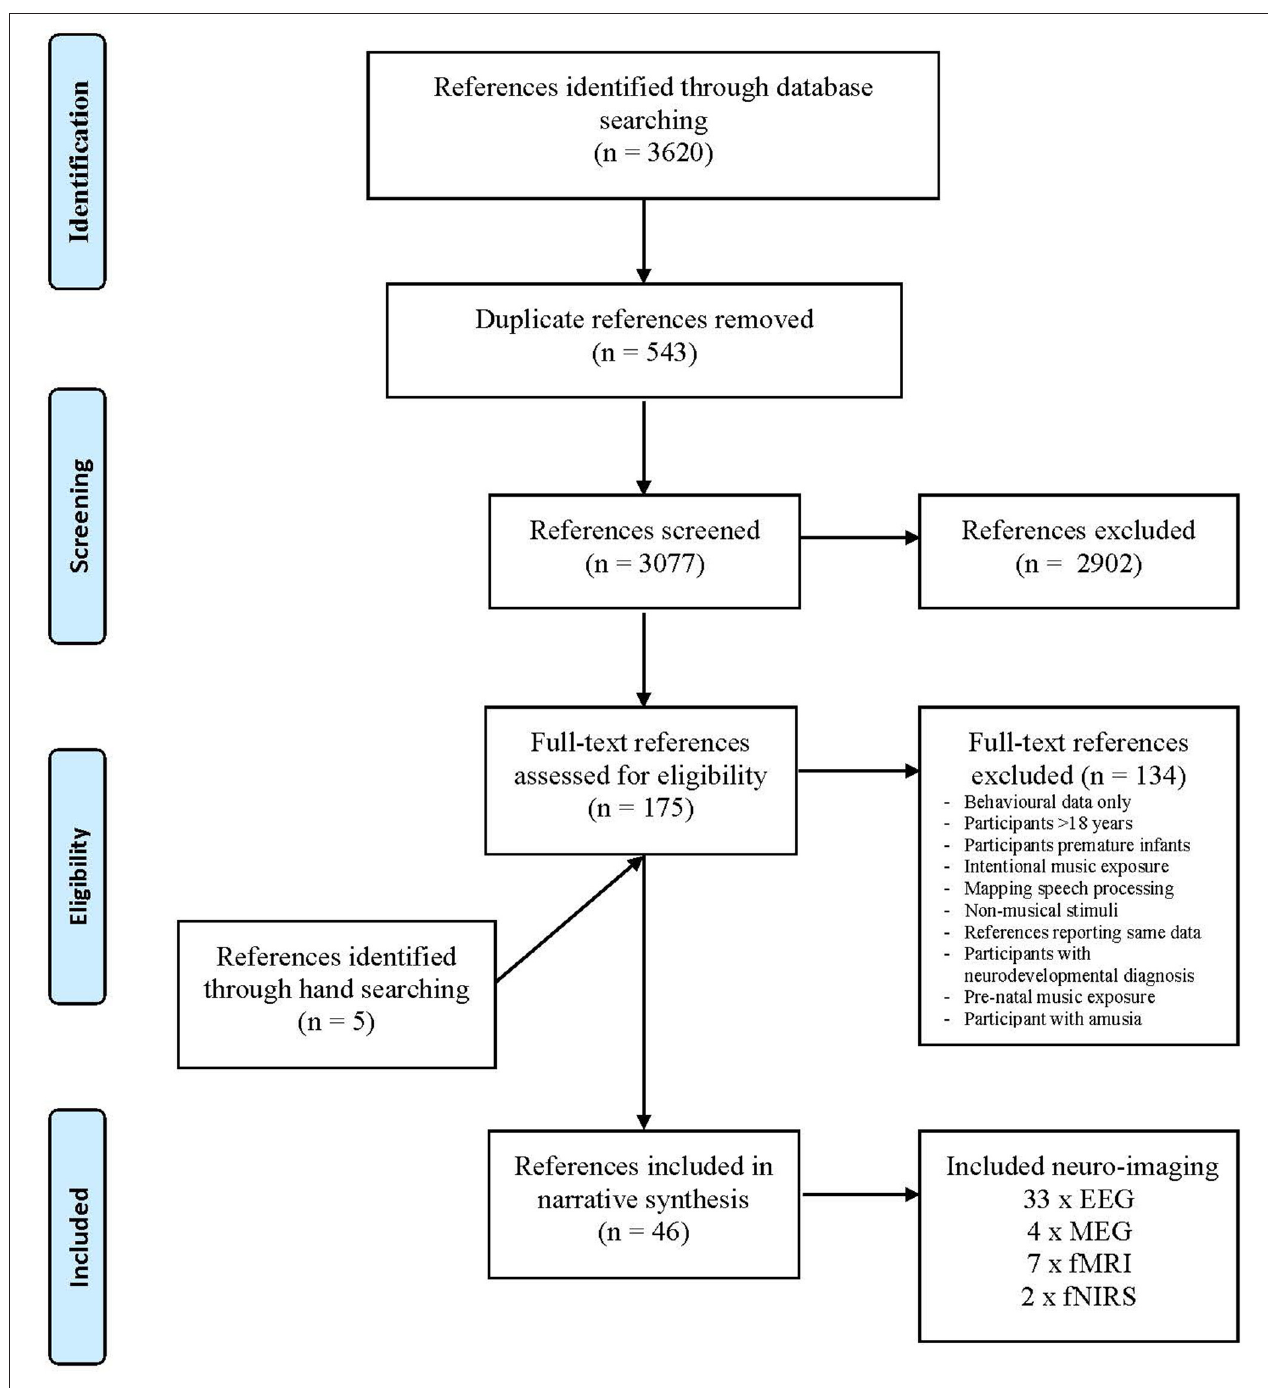
FIGURE 1 | Reference selection process. Adapted from Moher et al. (2009).